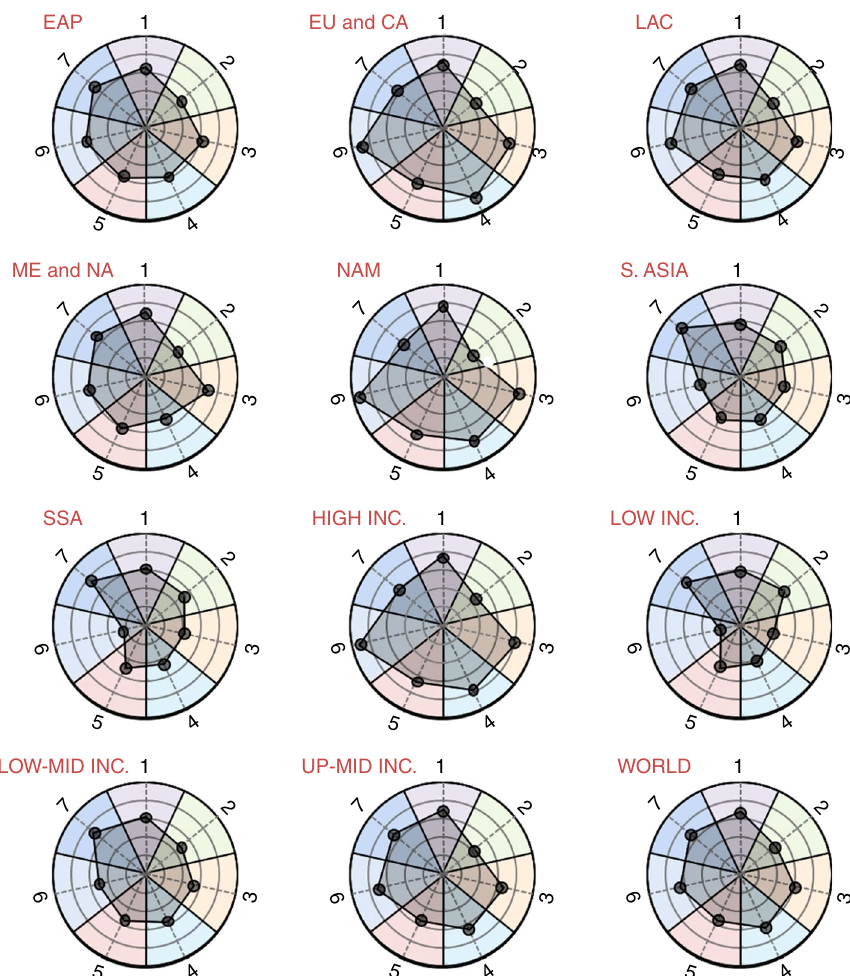
Fig. 4 Average food system metric scores for different World Bank regions and income levels. The areas of the polygons represent relative national status of food system sustainability (higher the better). The concentric circles are at intervals of 20. 1. Food Nutrient Adequacy; 2. Ecosystem Stability; 3. Food Affordability and Availability; 4. Sociocultural-Wellbeing; 5. Resilience; 6. Food Safety; 7. Waste and Loss Reduction. Regions are as follows: East Asia and Paci fi c (EAP); Europe and Central Asia (EU&CA); Latin America and Caribbean (LAC); Middle East and North Africa (ME&NA); North America